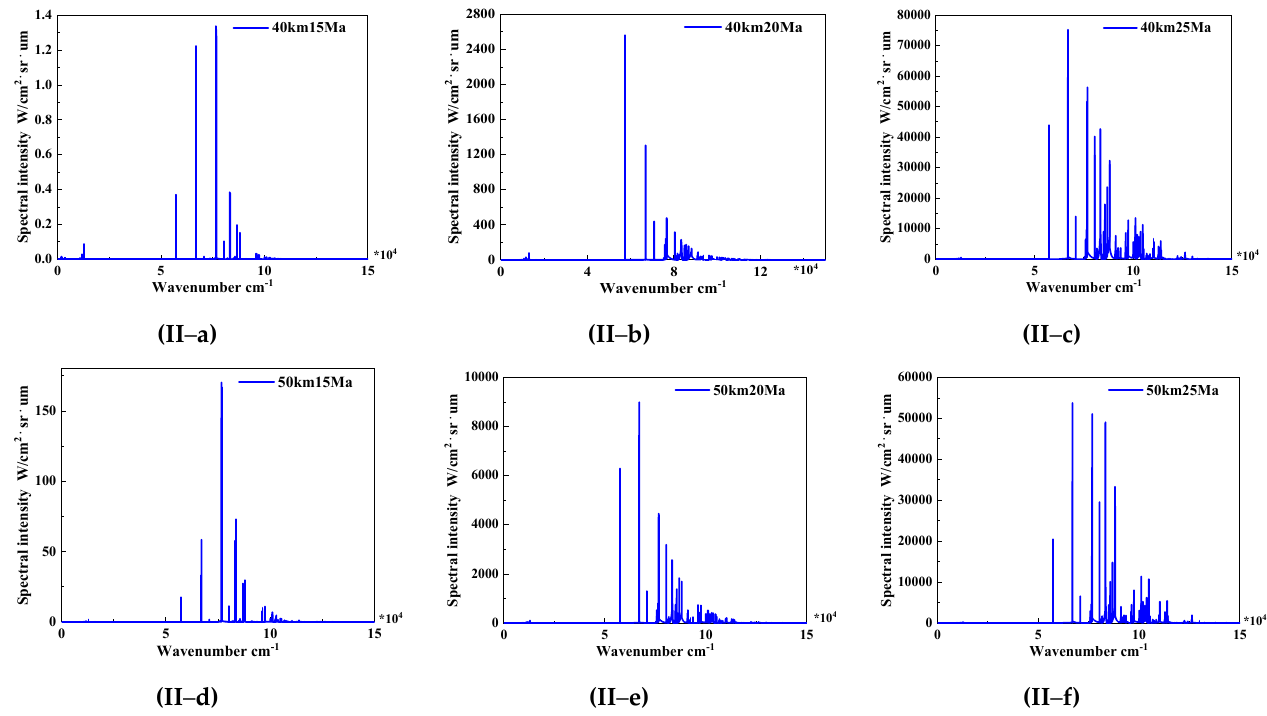
Figure 3. The simulated spectral radiation characteristic of HTs acquired by space-based detectors.